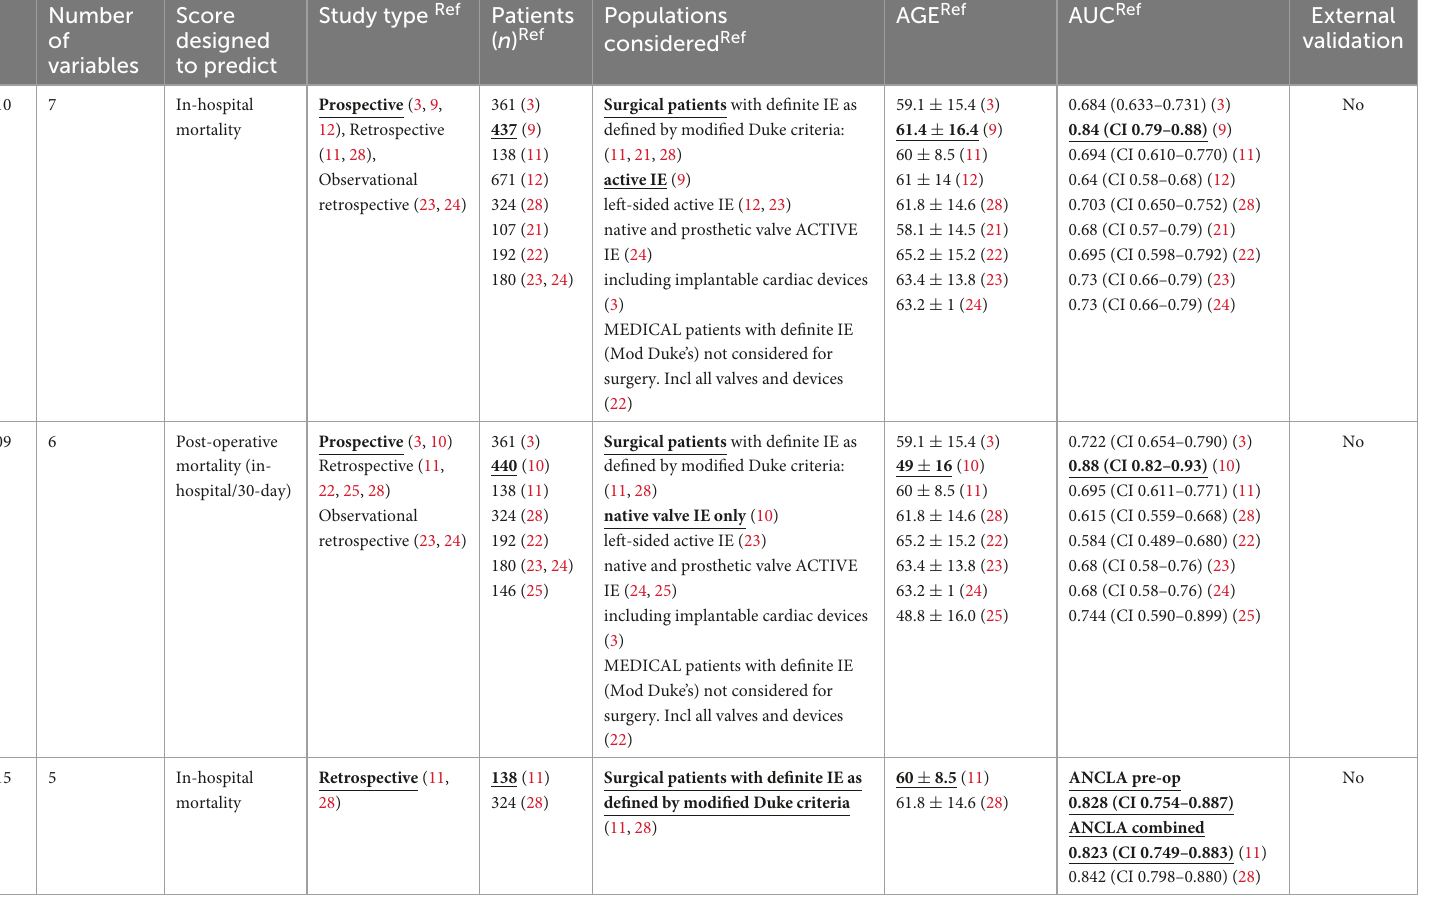
TABLE 1 Comparison of Risk Scores and their Performance–Risk Scores made for IE